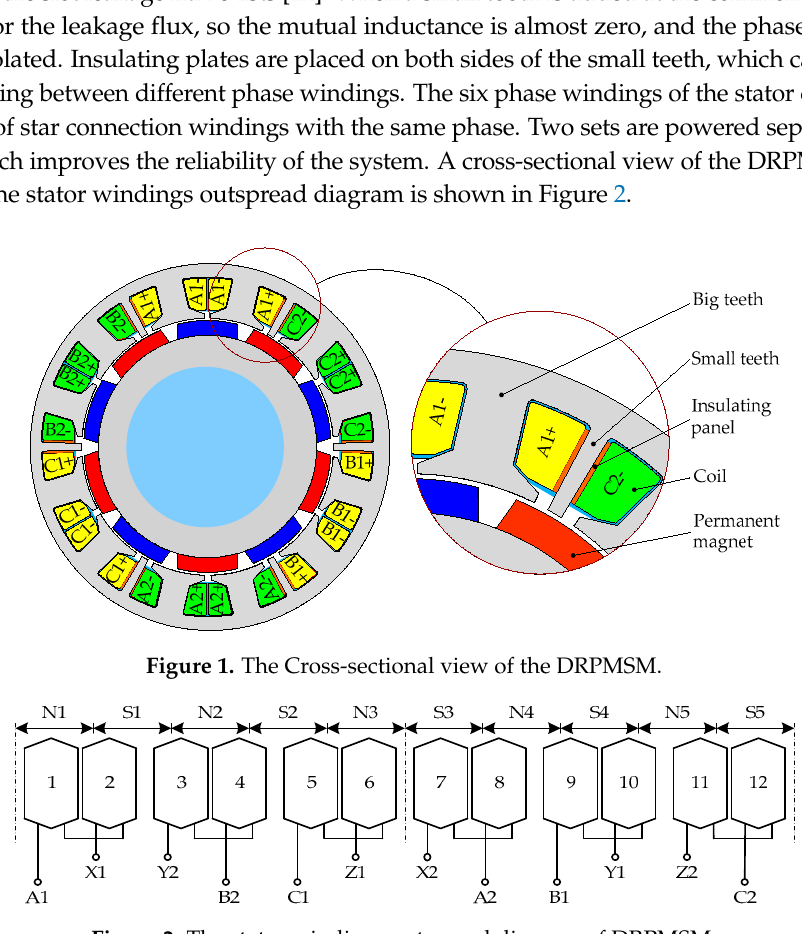
Figure 2. The stator windings outspread diagram of DRPMSM.